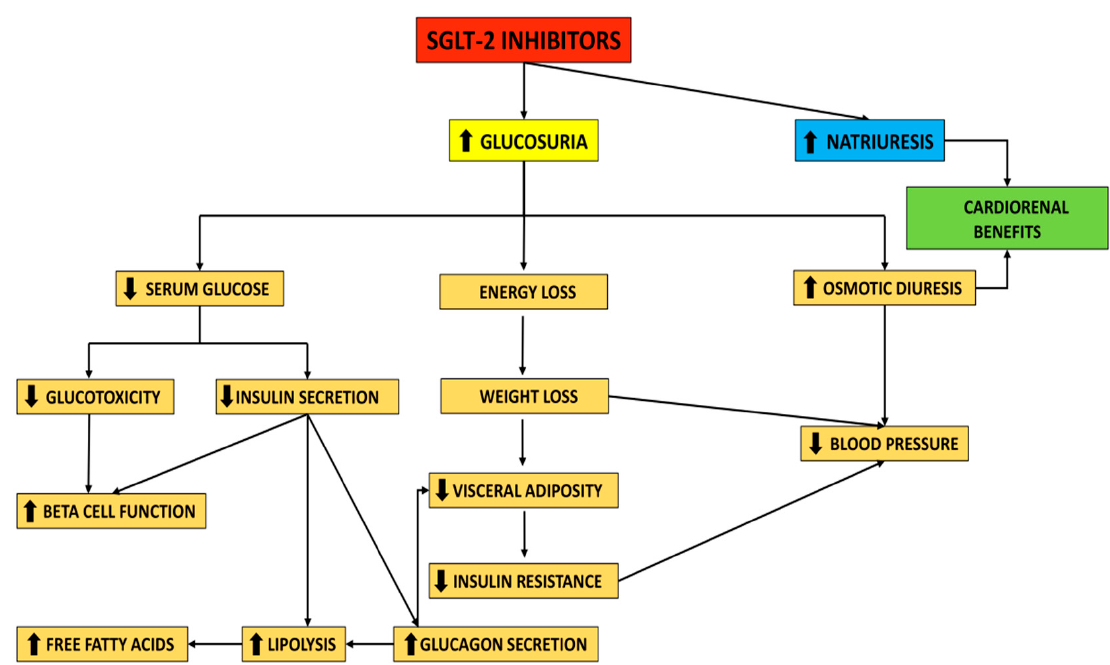
Figure 1. Mechanism of action of SGLT ‐ 2 inhibitors .